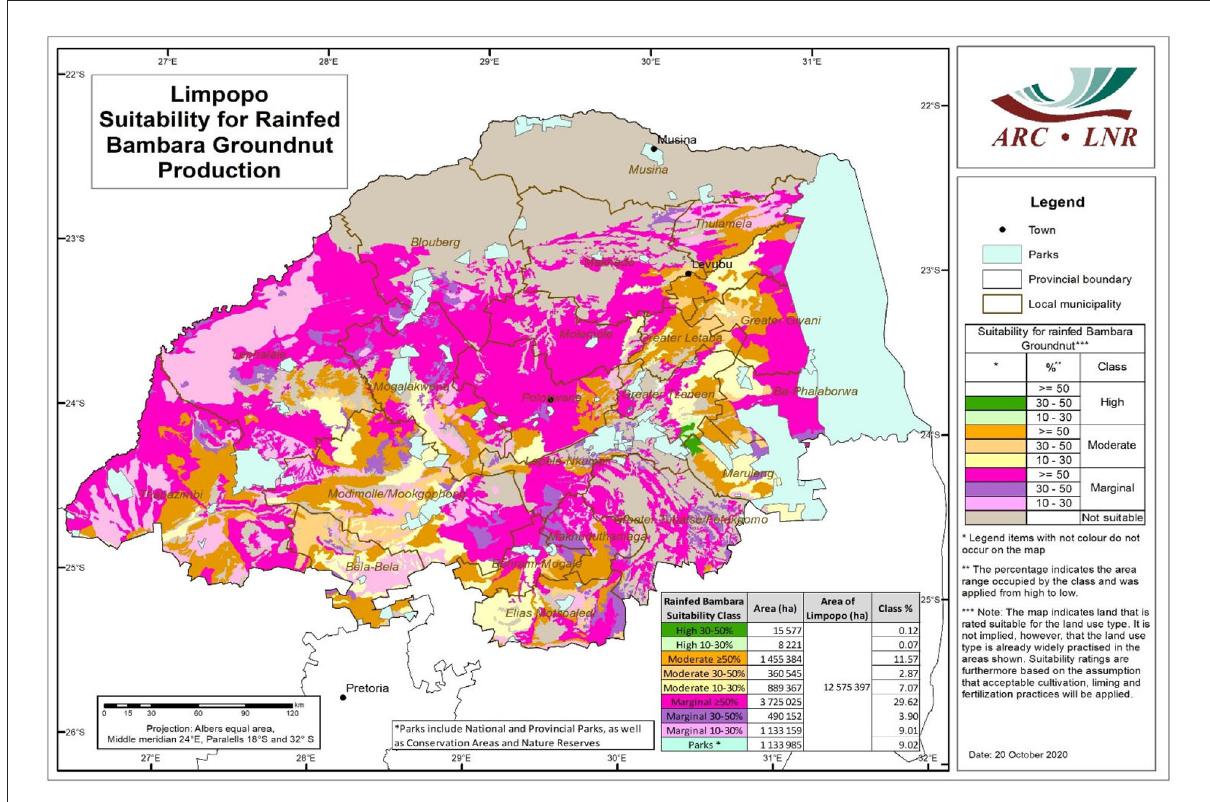
FIGURE3 Suitability map of Bambara groundnuts under dryland cultivation for Limpopo